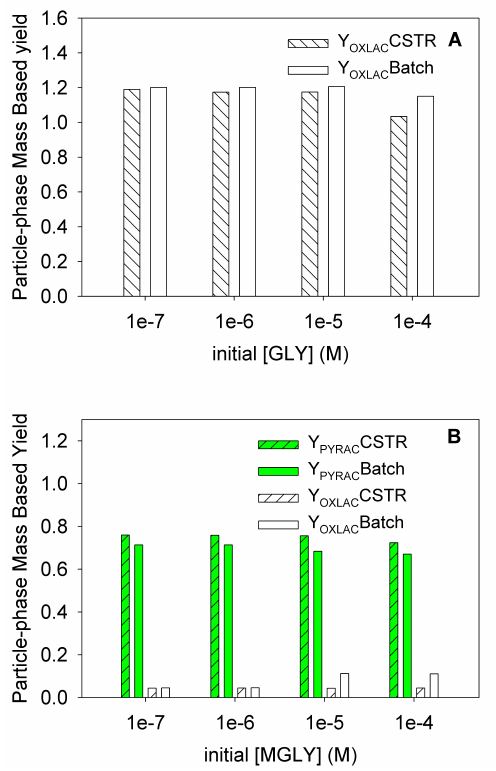
Fig. 10. The CSTR simulation and the batch simulation for particle- phase mass-based yields of oxalate ( Y OXLAC ) with increasing ini- tial concentrations of glyoxal for glyoxal + OH. (B) The CSTR simulation and the batch simulation for particle-phase mass-based yields of pyruvate ( Y PYRAC ) and oxalate ( Y OXLAC ) with increasing initial concentrations of methylglyoxal for methylglyoxal +